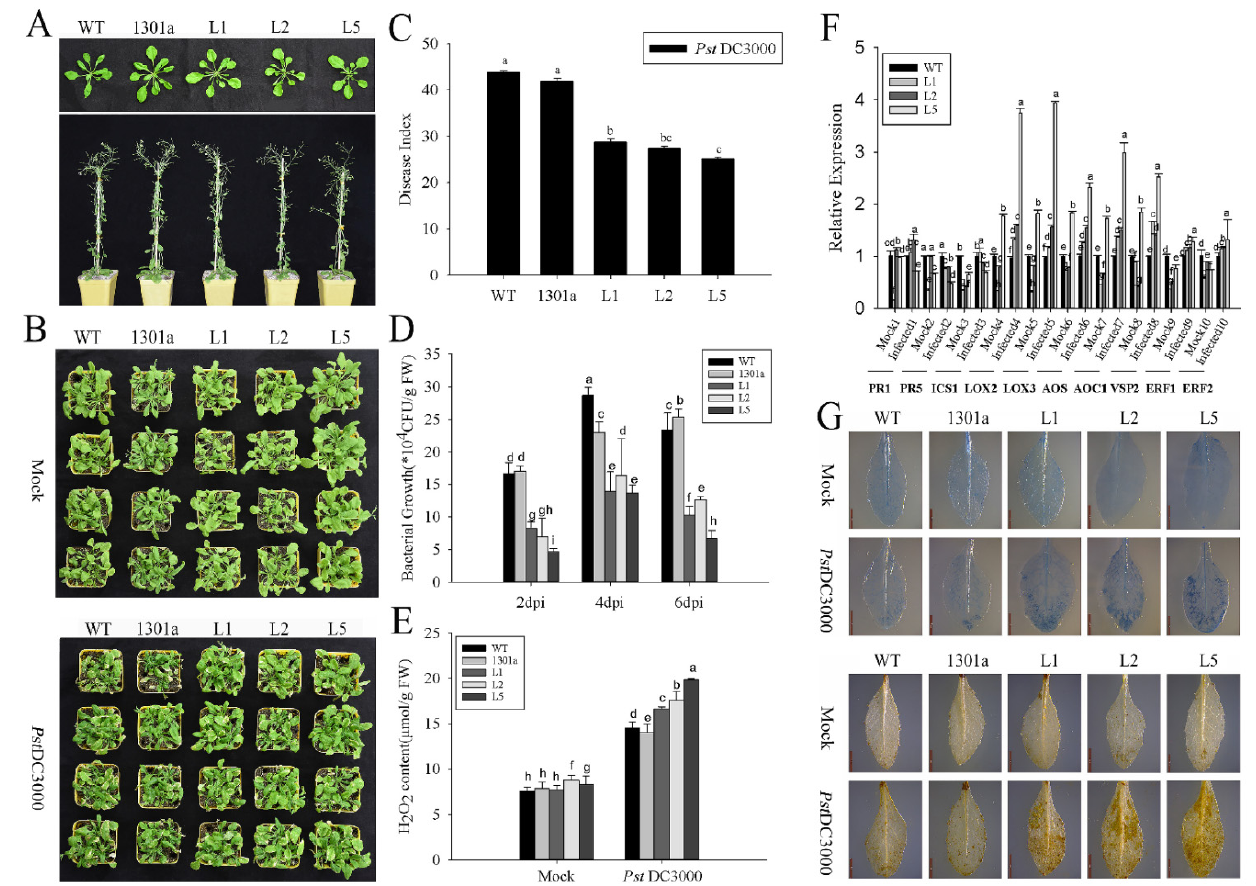
Figure 5. Expression of ZmGLP1 in Arabidopsis increases resistance to Pst DC3000. ( A ) Growth status of Arabidopsis leaves in different groups at four and seven weeks old. ( B ) Phenotypes of the different groups treated with Pst DC3000 at 7 d. ( C ) The disease indexes of groups at 7 d. ( D ) The population density of bacteria of different groups. ( E ) H 2 O 2 content of different groups at 3 d. ( F ) The expression levels of target plant genes of the salicylic acid, jasmonic acid, or ethephon pathway at 24 h. AtActin2 and AtTUB4 were used as reference genes for normalization. ( G ) Trypan blue staining and DAB staining in Arabidopsis leaves of different groups at 3 d. Different letters in subfigures ( C – F ) indicated significant difference between different samples by Duncan’s post-hoc test. Data are presented as the mean ± SD based on three biological replicates.